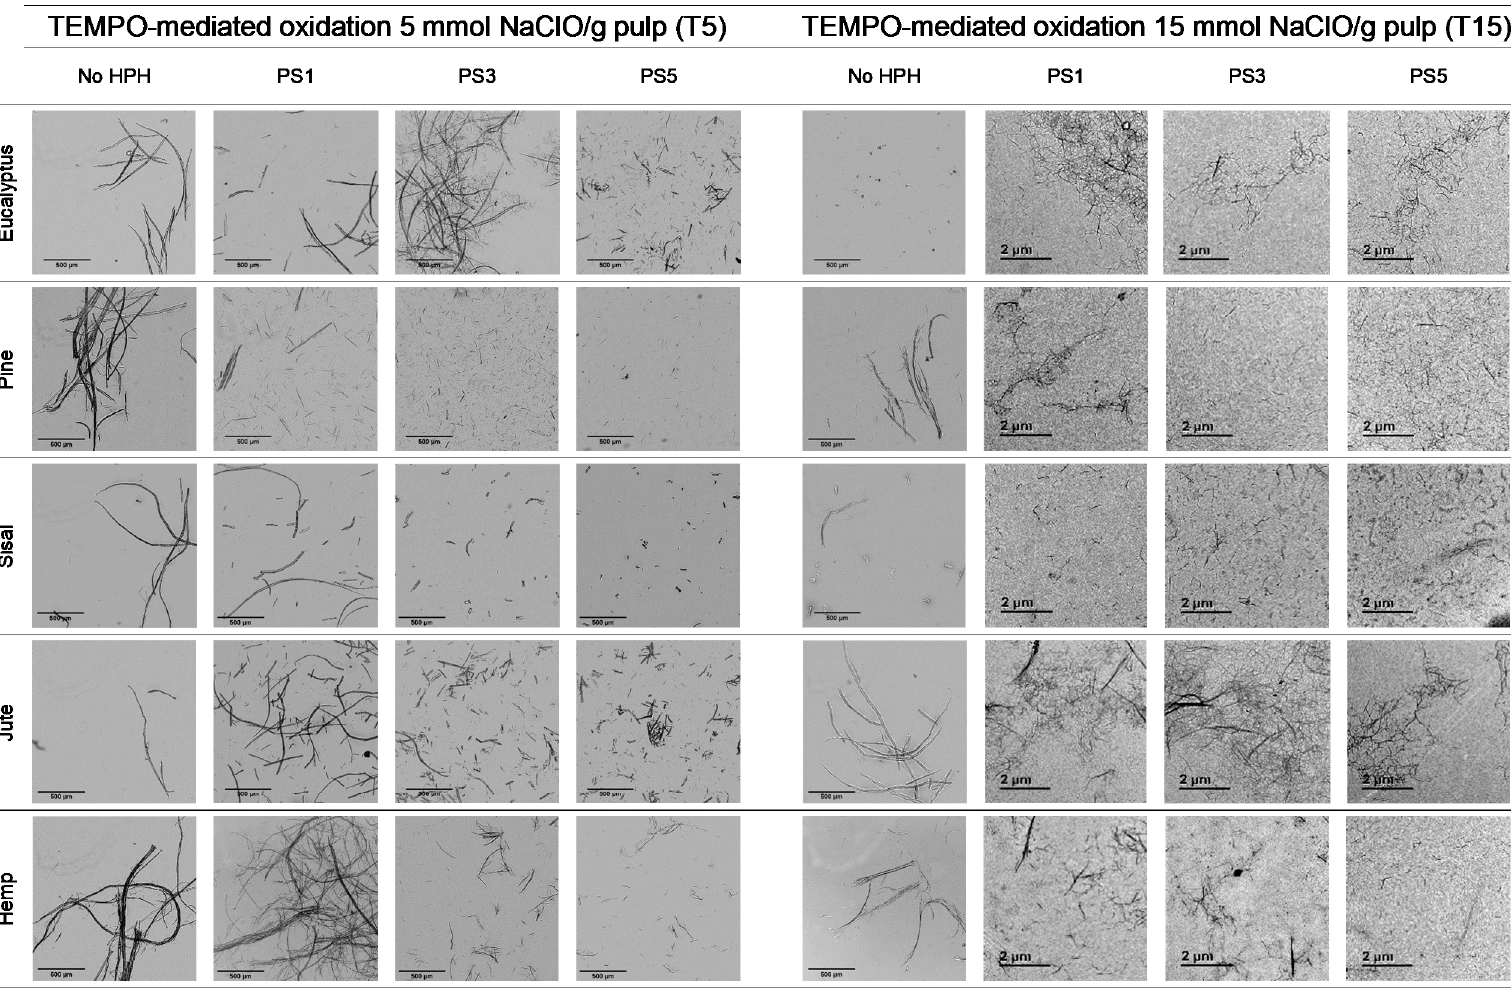
Figure 5. Optical microscopy images at 5× magnification and transmission electron images (TEM) of pretreated cellulose and CNFs with the TEMPO-mediated oxidation pretreatment.